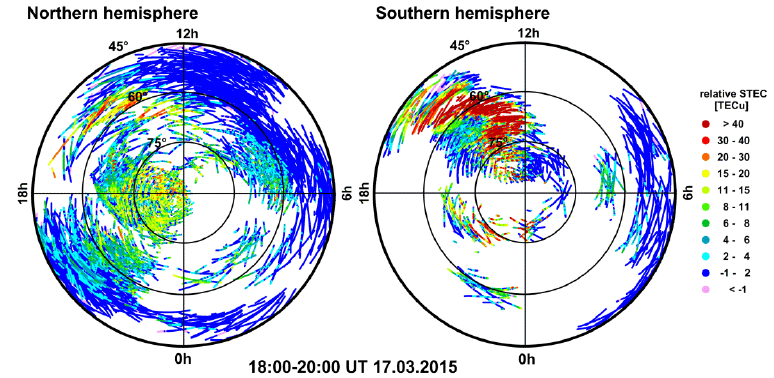
Figure 10. The distribution of relative STEC values as a function of AACGM latitude and MLT obtained for both hemispheres (18:00 – 20:00 UT on 17 March